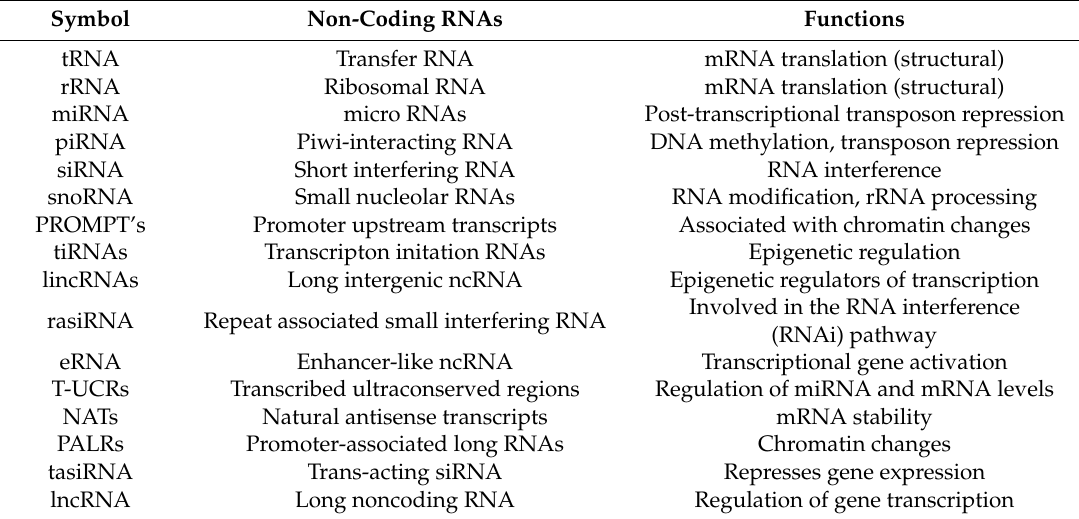
Table 1. Classes of non-coding RNAs